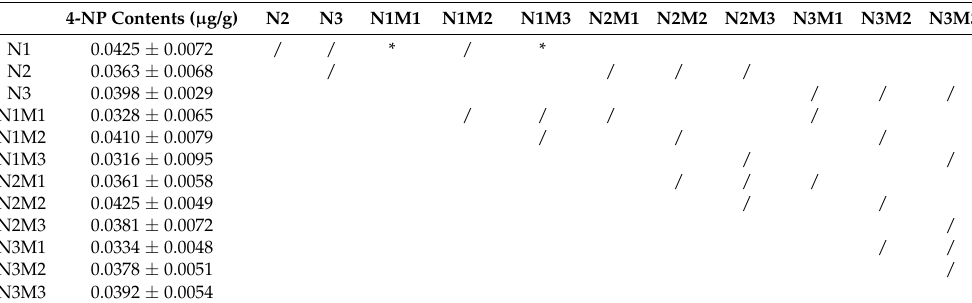
Table 10. Statistical analysis of 4-NP contents in gill at Day 15.